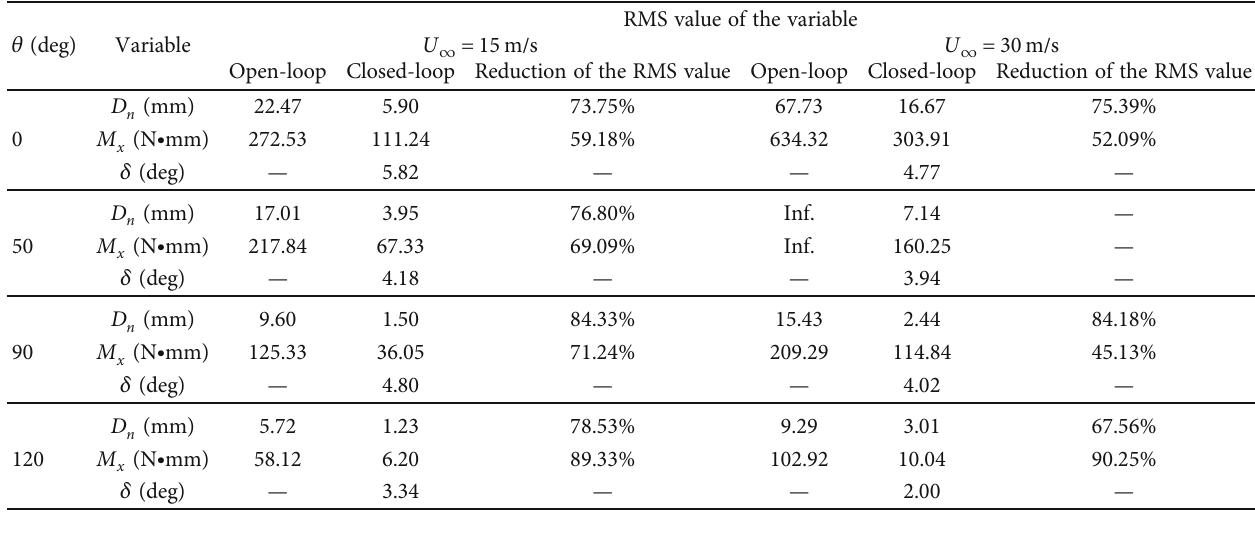
Table 2: RMS values of the wing-tip displacement ( D gust responses.